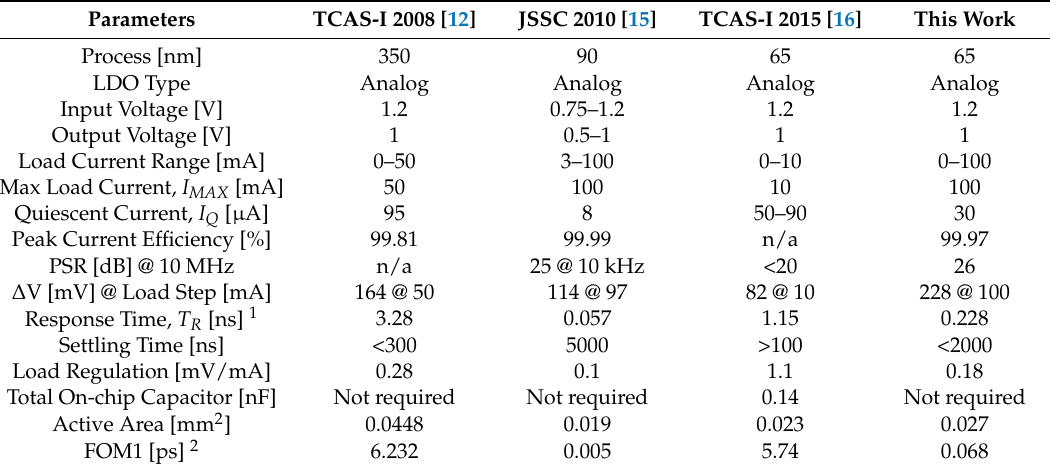
Figure 13. Measured load–transient response of the proposed LDO regulator with load current variation (0–100 mA). Table 1. Performance comparison of capacitor-less LDOs.